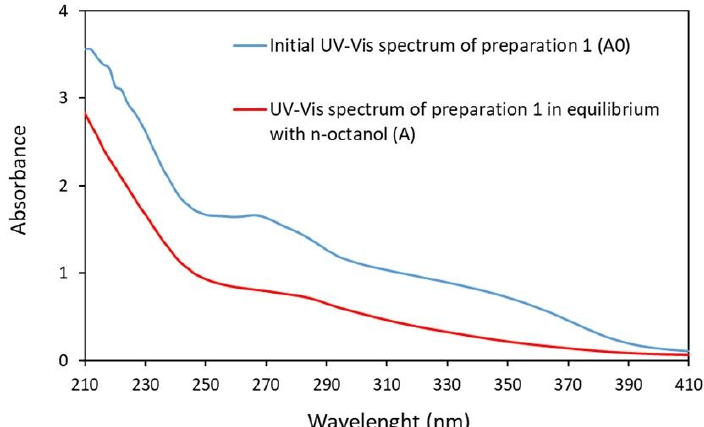
Figure 5. An example of the UV ‐ Vis spectrum of the preparation obtained from the leaves of Rubus idaeus L.